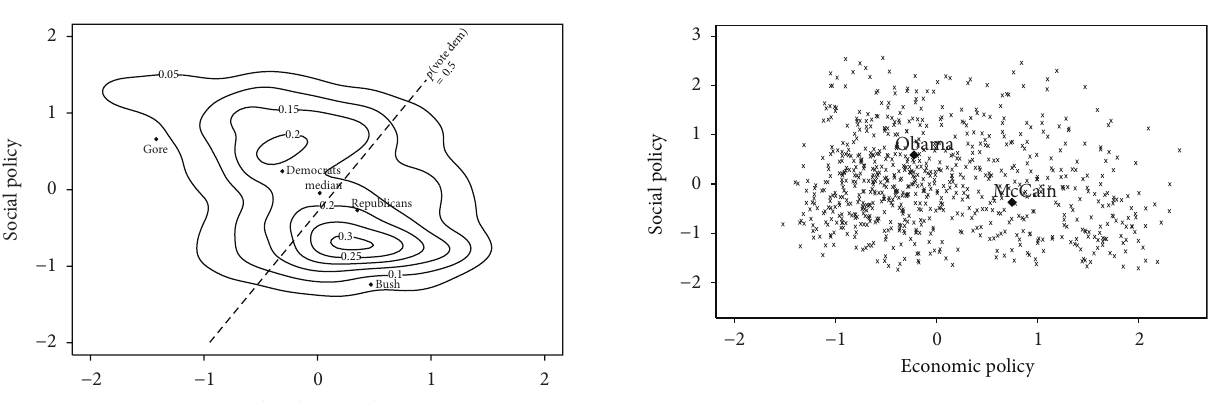
Figure 3: Distribution of voter ideal points and candidate positions in the 2008 US